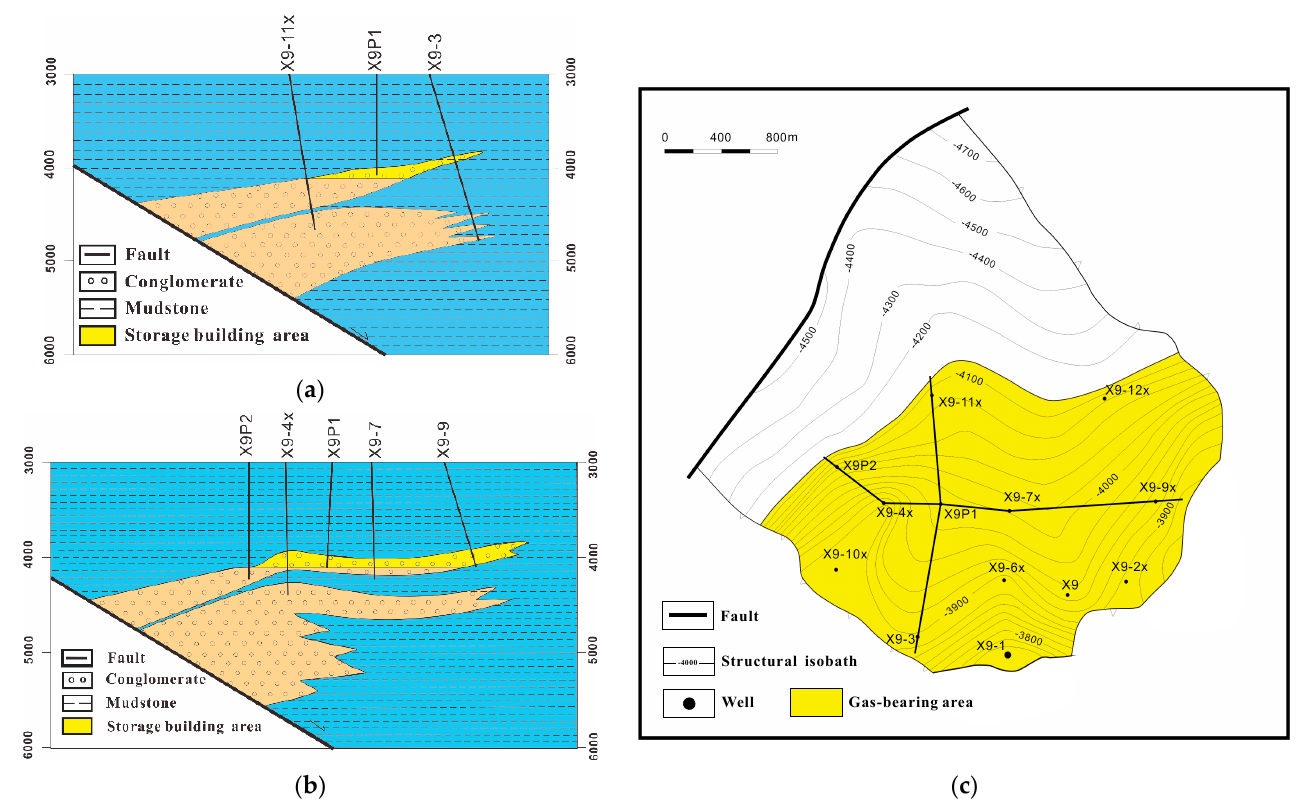
Figure 7. Profiles of connected wells in X9 gas reservoir: ( a ) X9 - 11x~X9P1~X9 - 3; ( b ) X9P2~X9P1~X9 - 9x; ( c ) Top structure diagram.